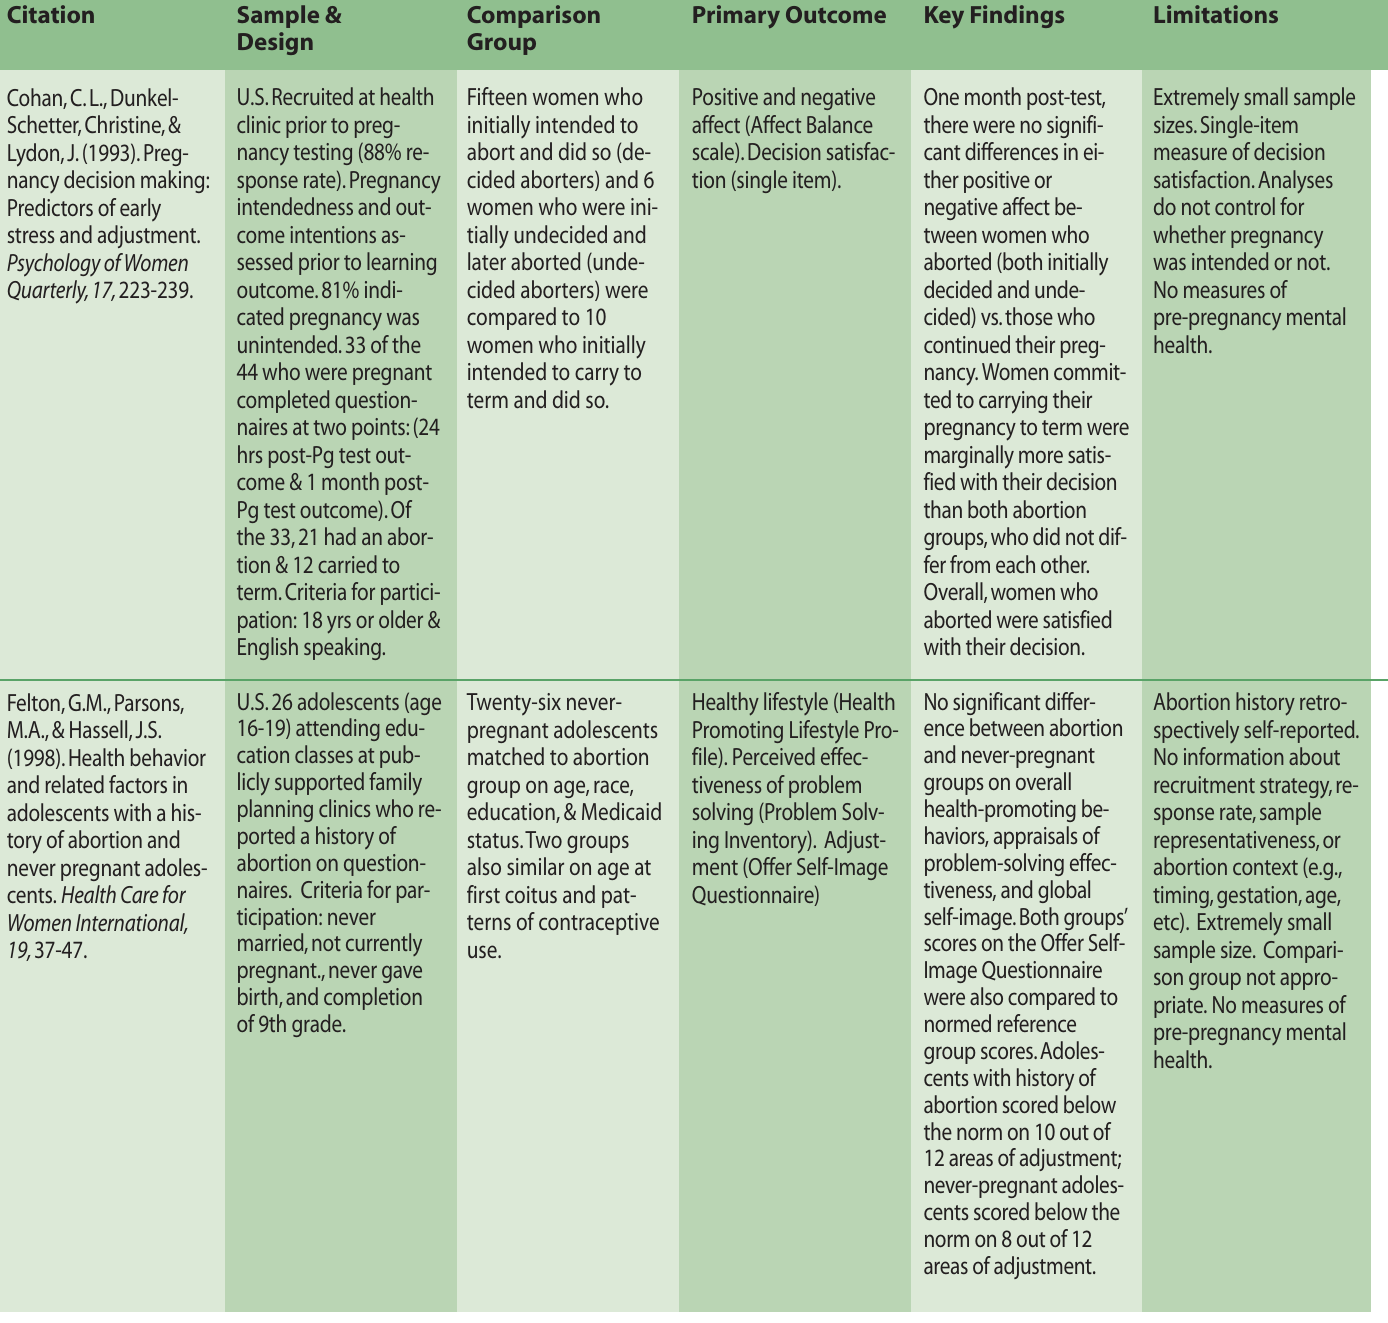
Table 3A: Primary Data Comparison Group